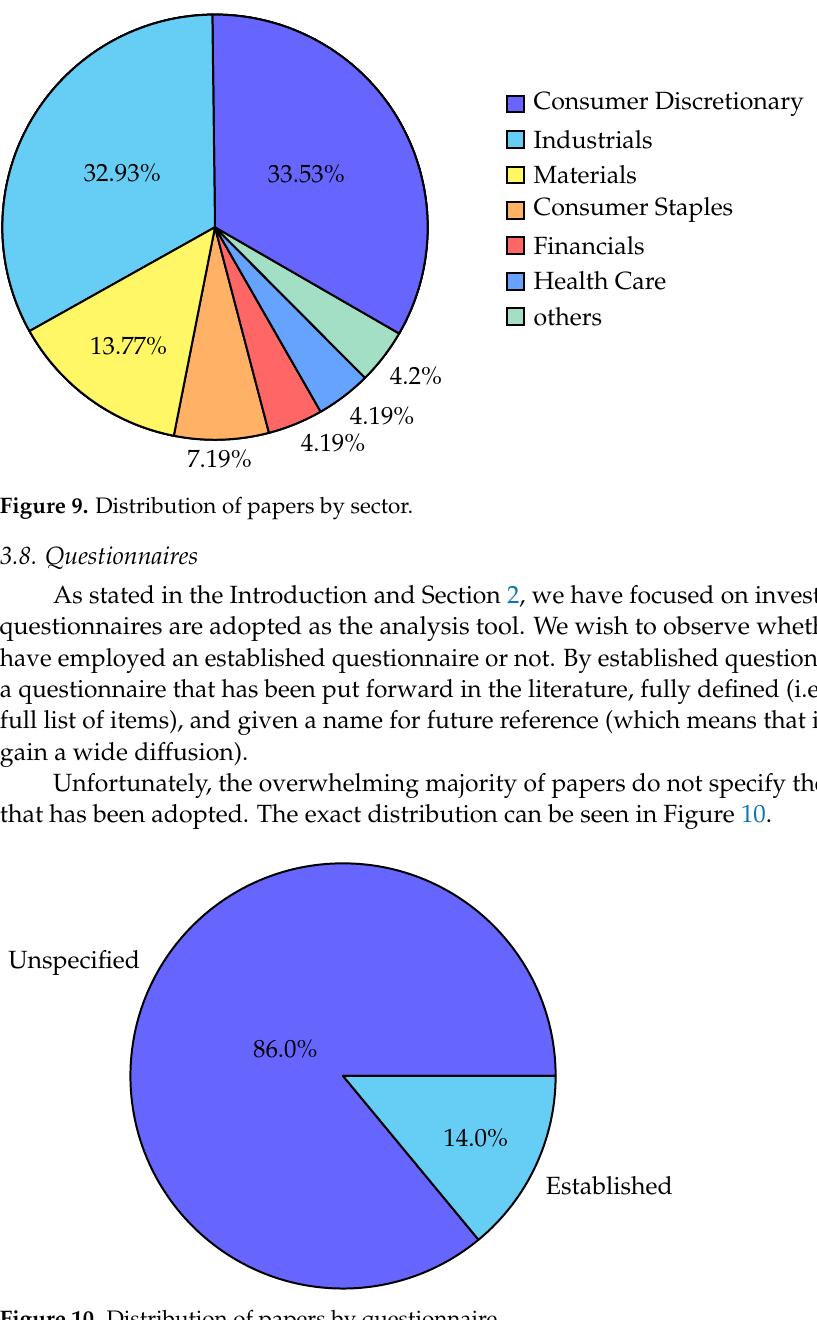
Figure 10. Distribution of papers by